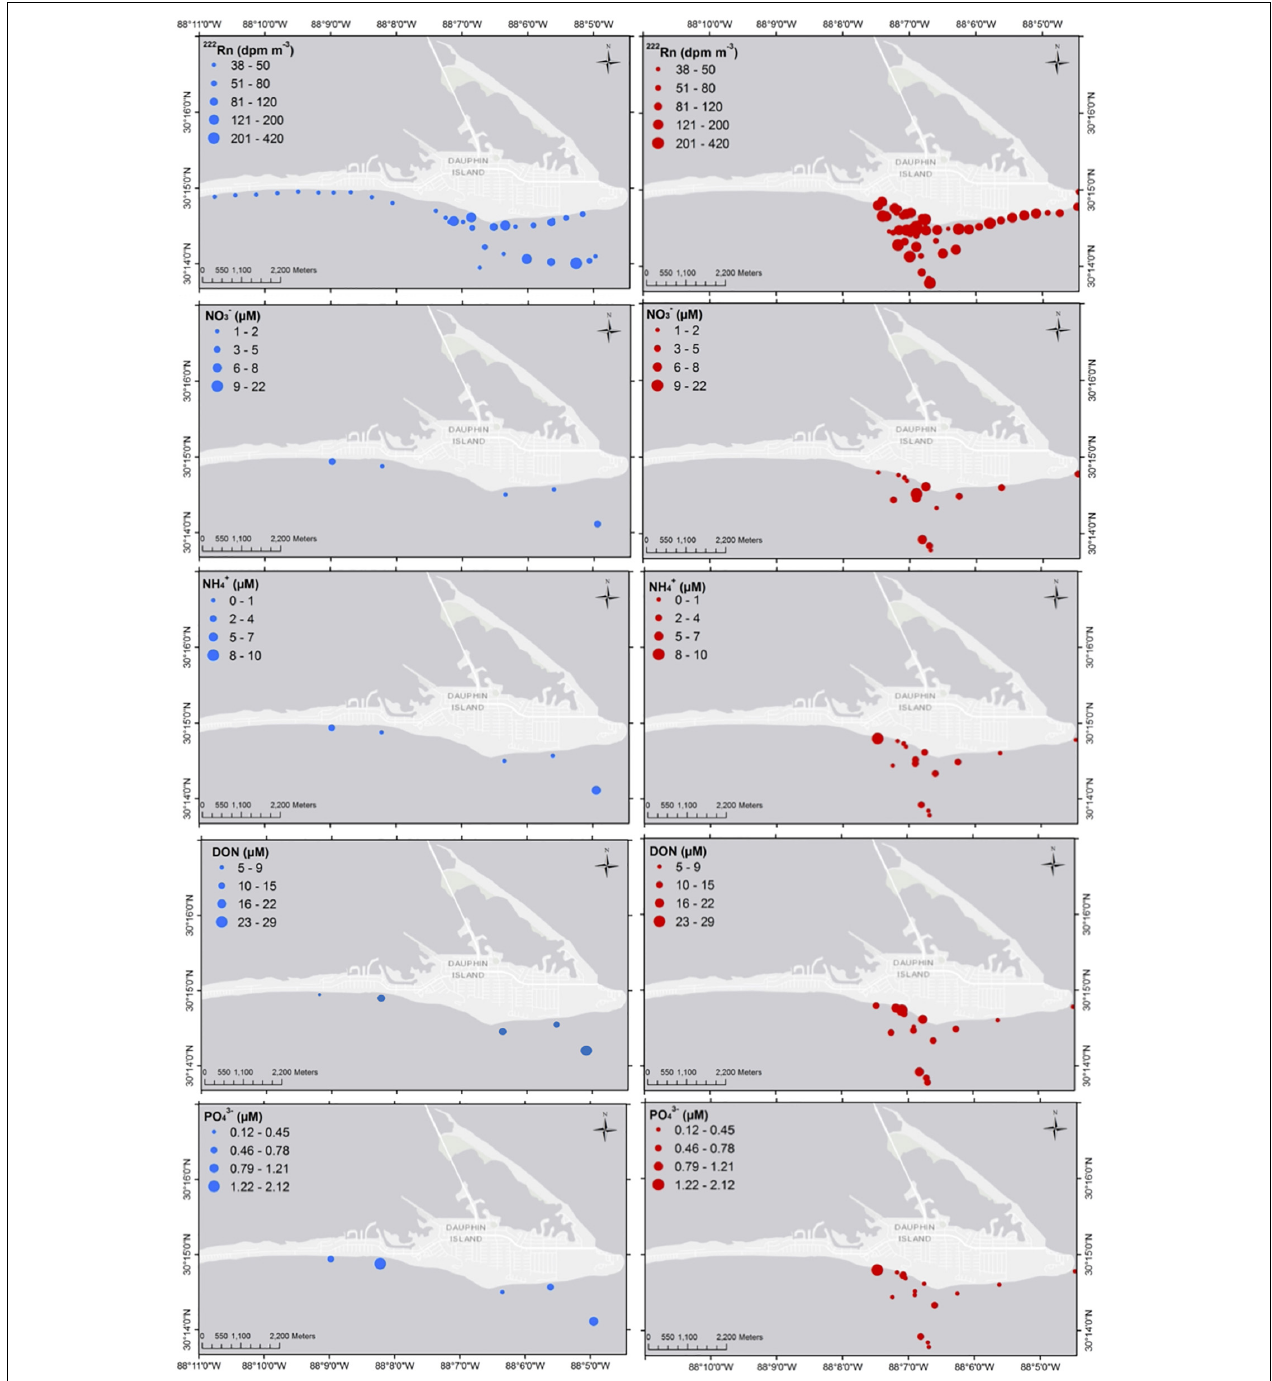
FIGURE 2 | Spatial distribution of 222 Rn and nutrients in coastal waters along the ocean side of Dauphin Island in 2014 (left) and 2016 (right).